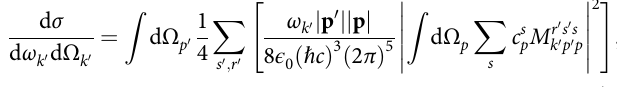
Figure 2 considers bremsstrahlung radiation where the scat- tering potential A μ is that of a neutral carbon atom, modeled using a sum of three Yukawa potentials fi tted to the results of relativistic Hartree – Fock calculations, which agree well with experimental measurements 116,117 (see the Methods section). In all cases, the result is averaged over output spin and photon polarization, while the input electron states are taken to be spin- up. Figure 2a, b illustrates the two scenarios under consideration: